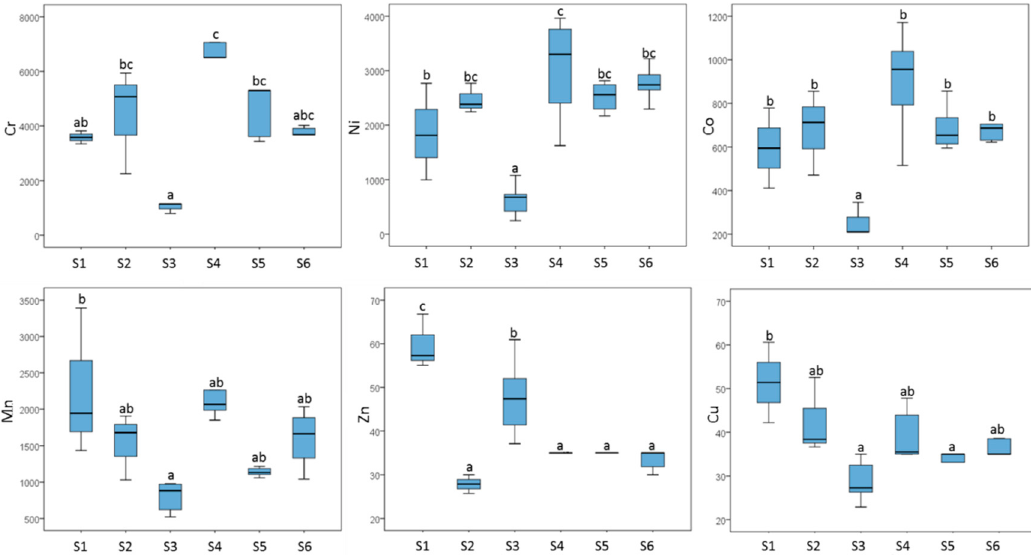
Figure 3. Boxplot for the trace elements (Cr, Ni, Co, Mn, Zn, and Cu) for which there were significant differences among sub-units (S1–S6). The lower and upper limits of the whiskers indicate 5% and 95% values, respectively; boxes extend from 25th to 75th percentiles; horizontal lines within the boxes represent medians. Letters mean significant difference among samples (Tukey, p < 0.05).